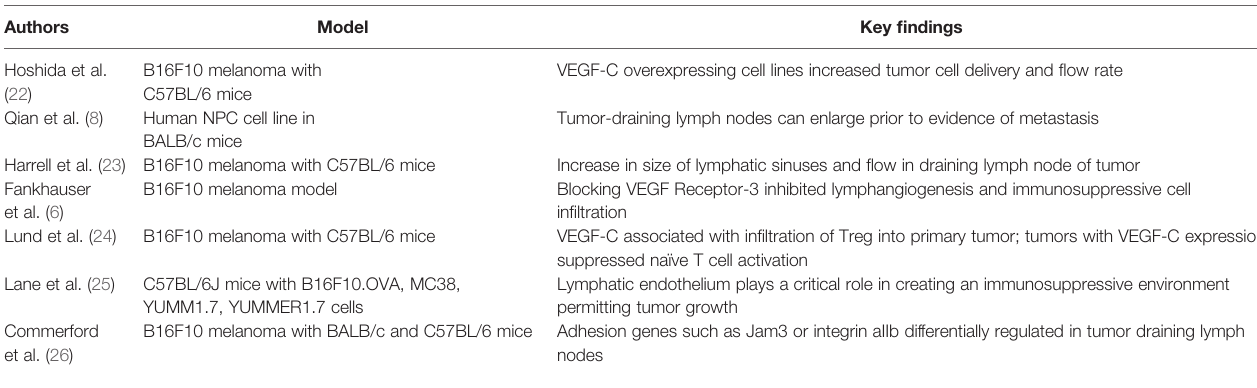
TABLE 3 | Mechanistic studies evaluating melanoma metastasis.